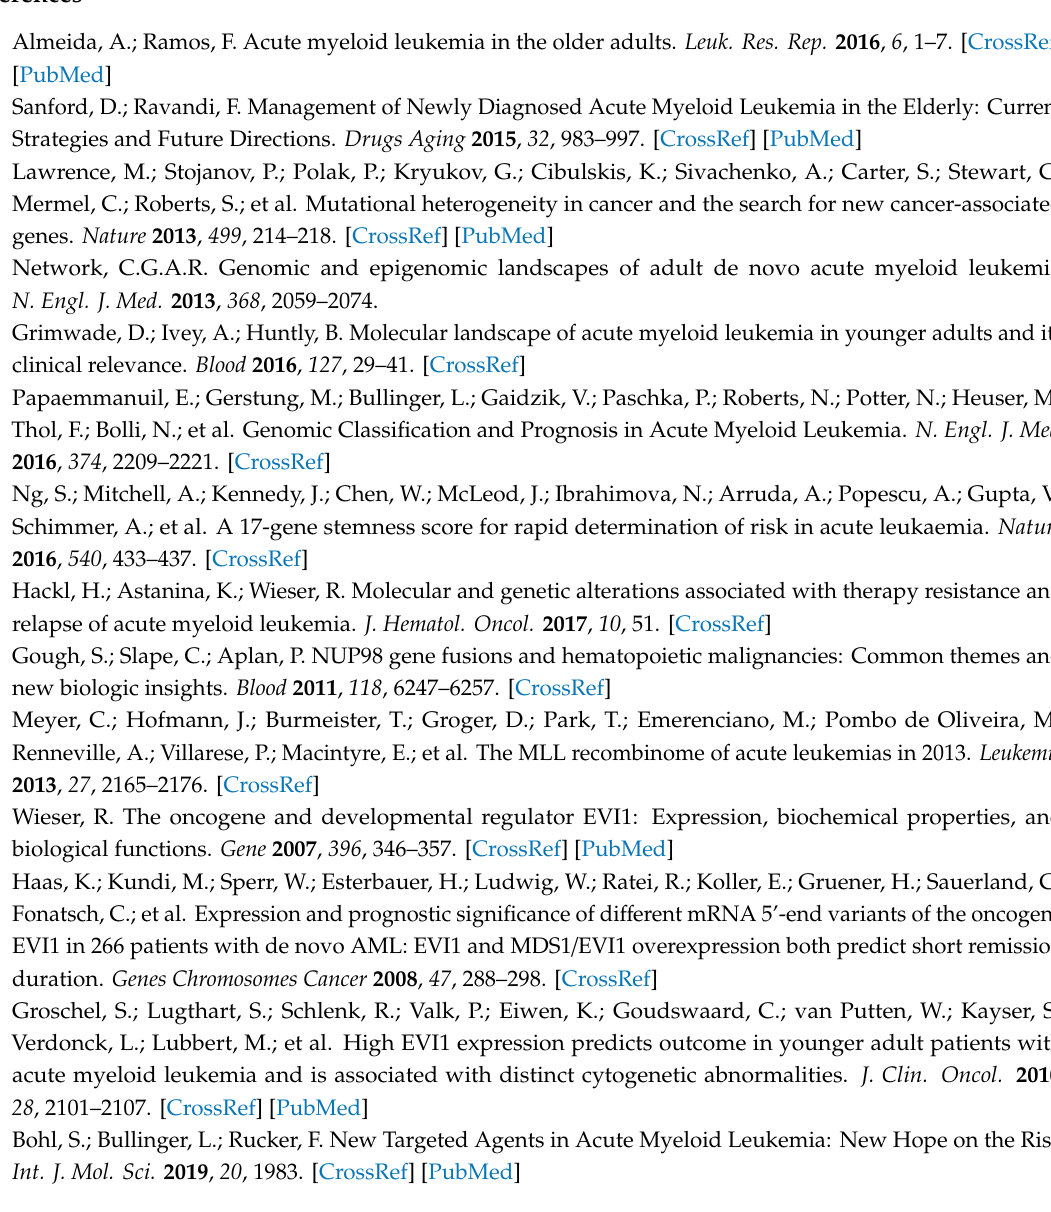
e ff ects. An enhanced understanding of the e ff ects of retinoids on LSCs may ultimately facilitate the development of precision medicine-based retinoid therapy for certain subgroups of